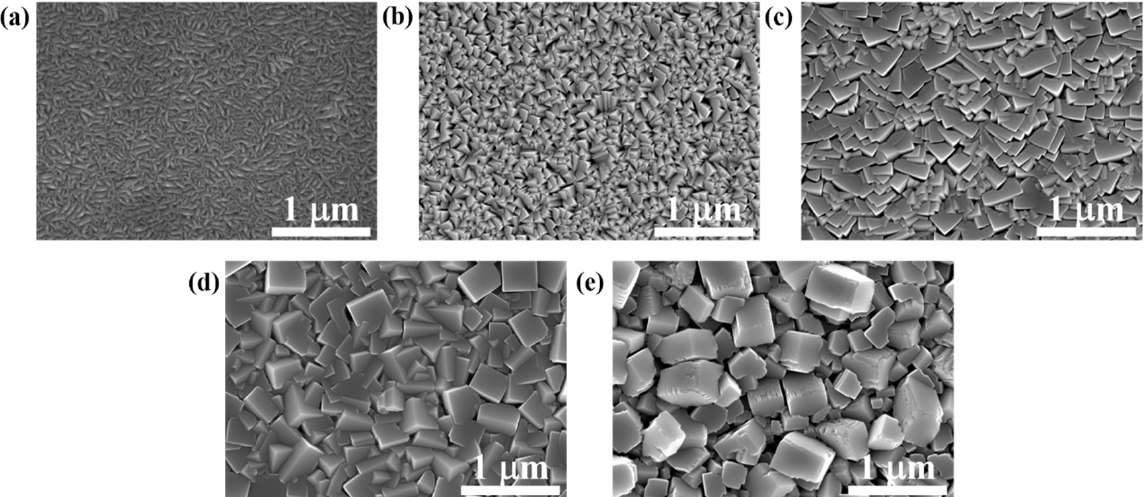
Figure 6. Surface morphologies of FeCo thin films with thickness of 800 nm deposited at ( a ) 25 °C,